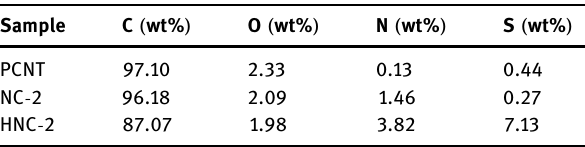
Table 1: Element analysis results of PCNT and modi fi ed fi lms ( NC - 2, HNC - 2 )